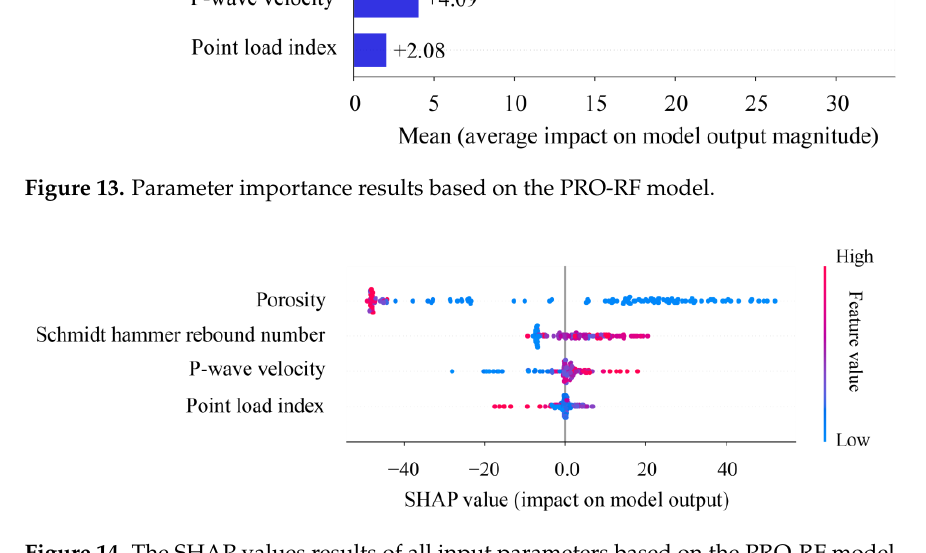
Figure 14. The SHAP values results of all input parameters based on the PRO-RF model.